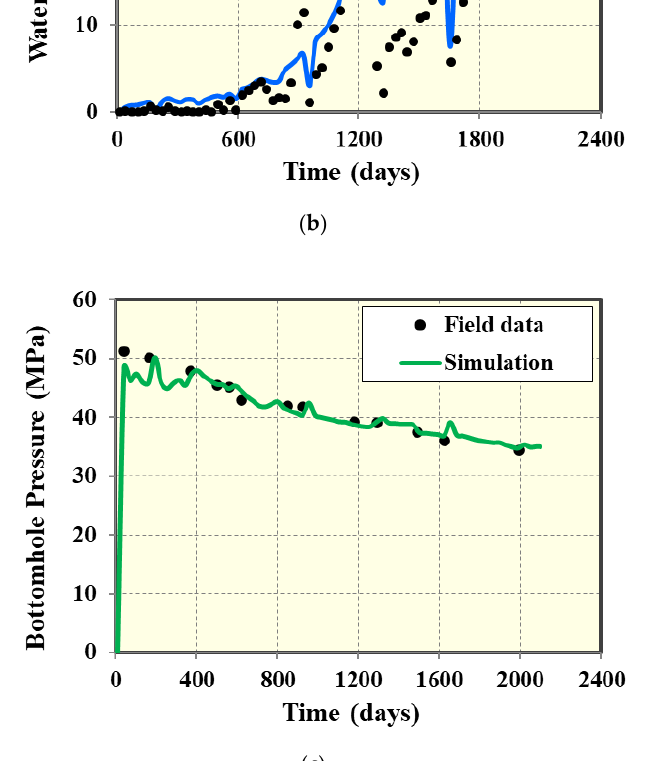
Figure 36. Final simulation and history matching results of five-well group: ( a ) gas flow rate; ( b ) water